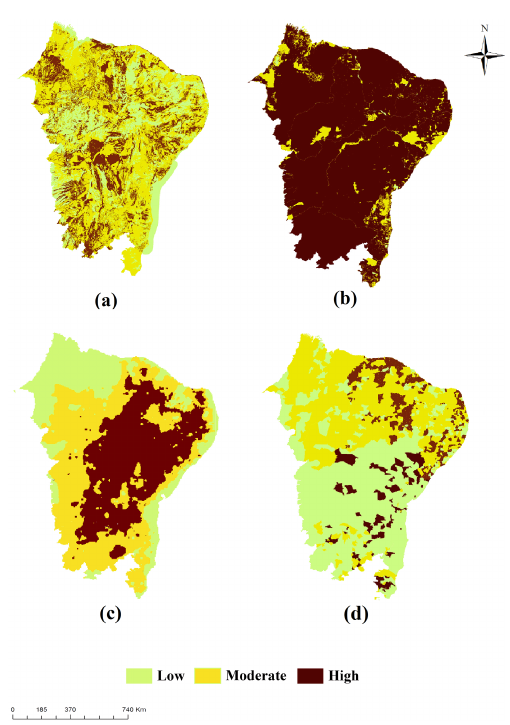
Figure 3. (a) Physical land quality index; (b) management quality index; (c) climate quality index; (d) social quality